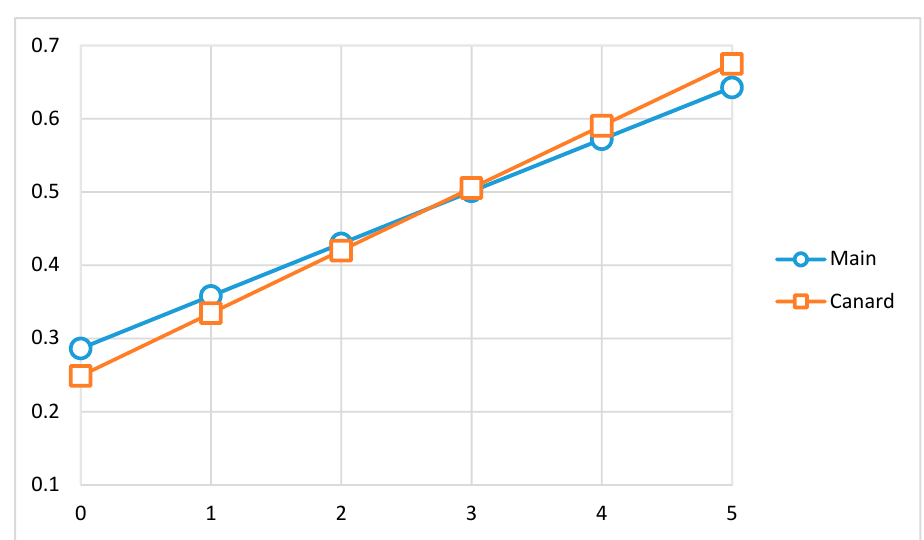
Figure 4. Vahana CL calculated using OpenVSP.